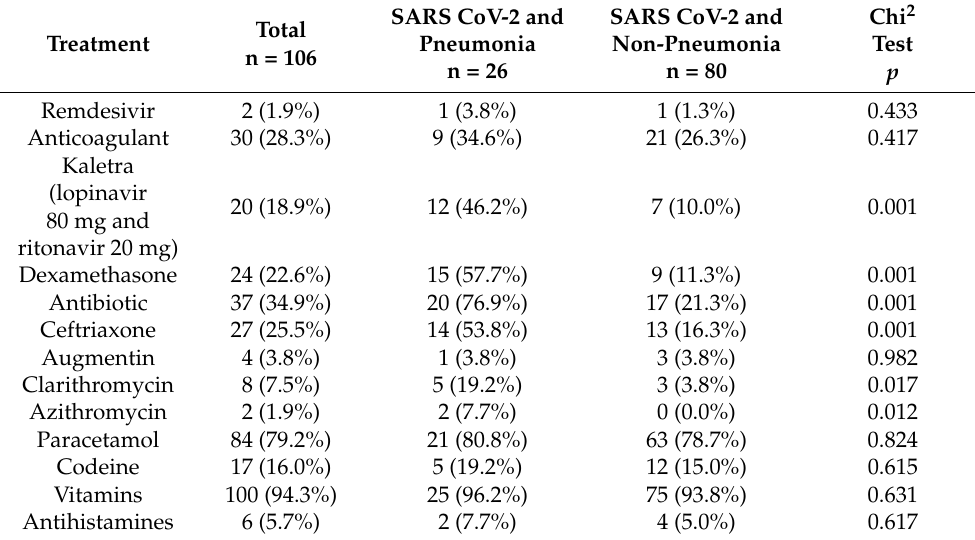
Table 8. Treatments in SARS CoV-2 patients with